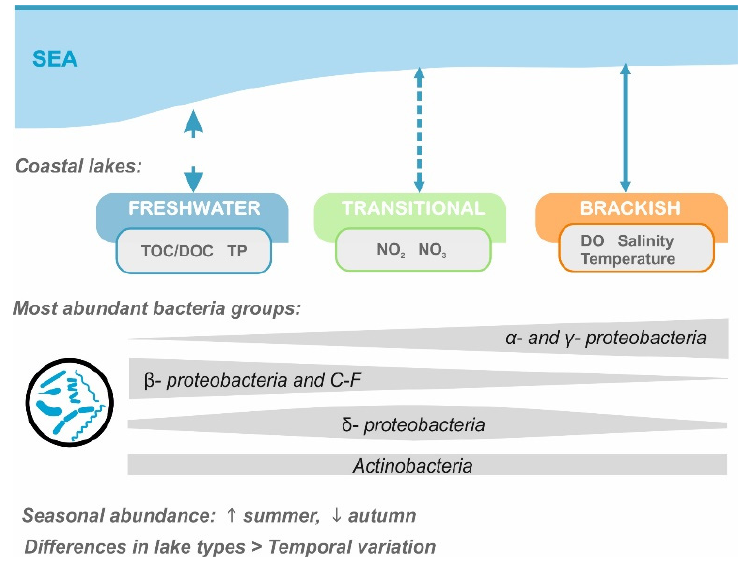
Figure 5. Summary diagram of the response of microbial community structure to the salinity stress and physico-chemical parameters of water in coastal lakes.